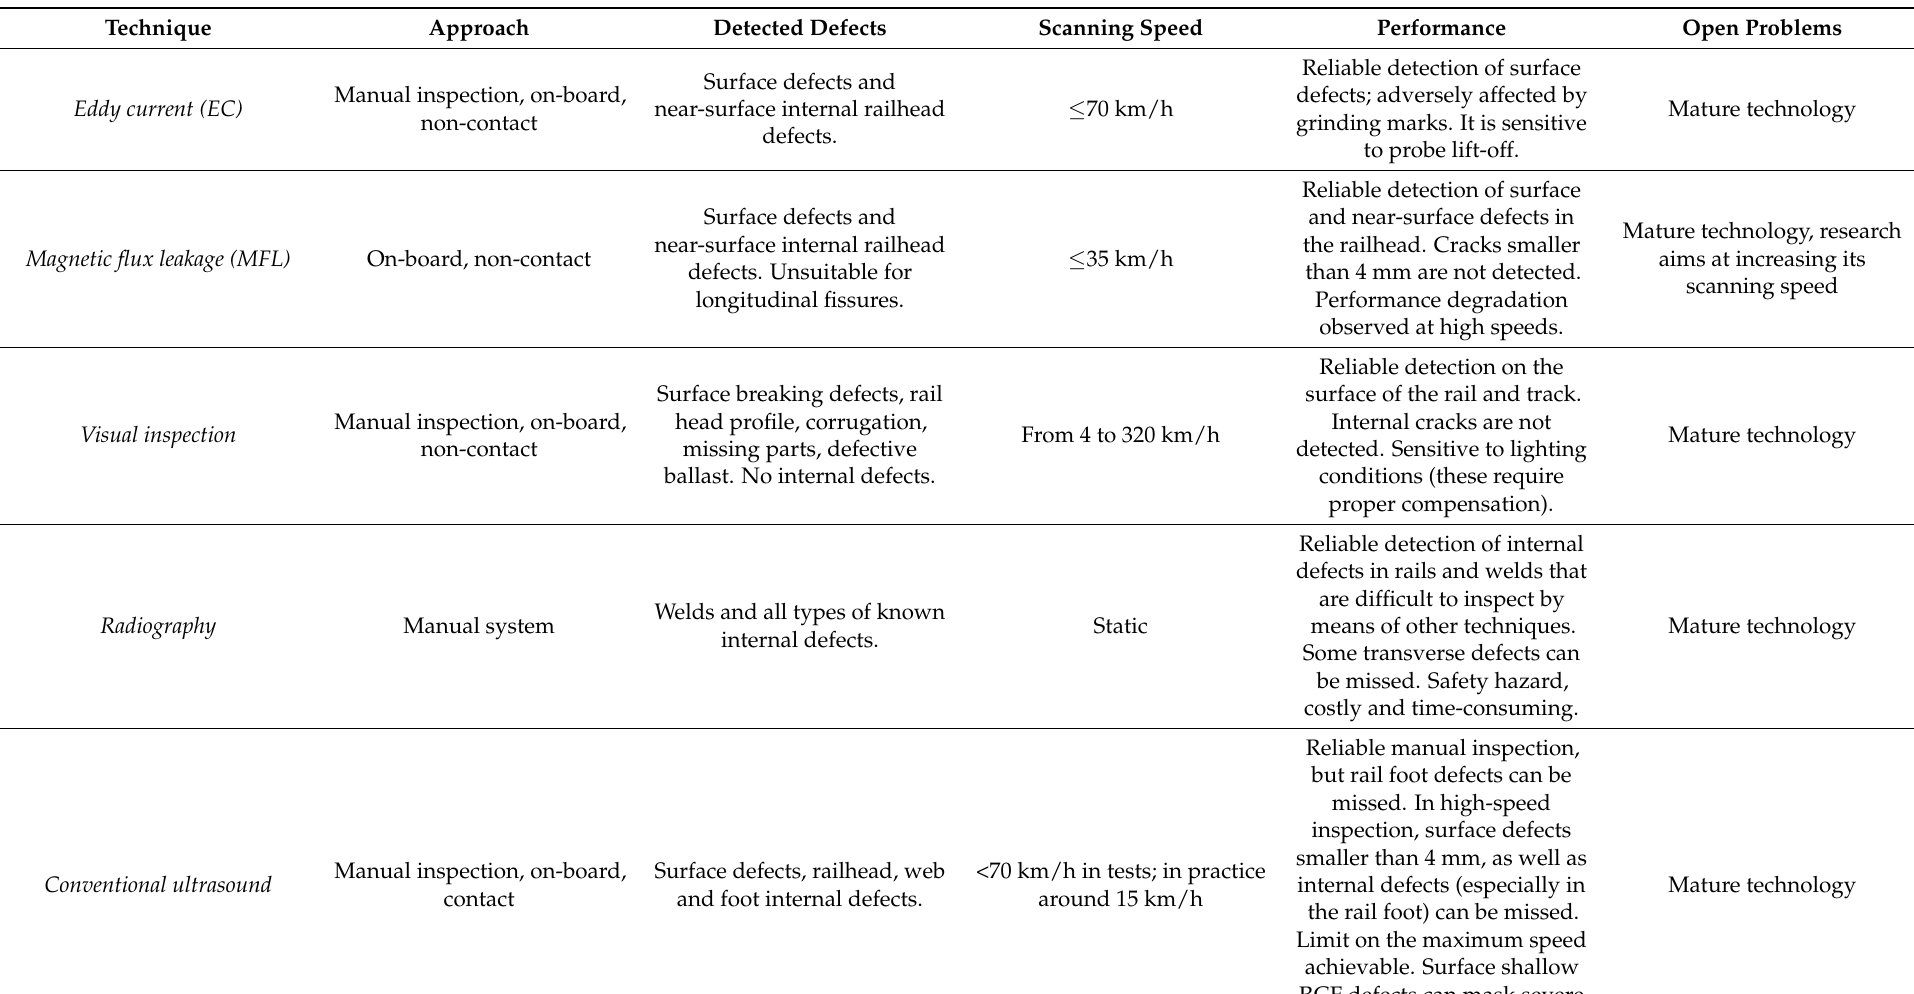
Table 4. NDT techniques for rail defect